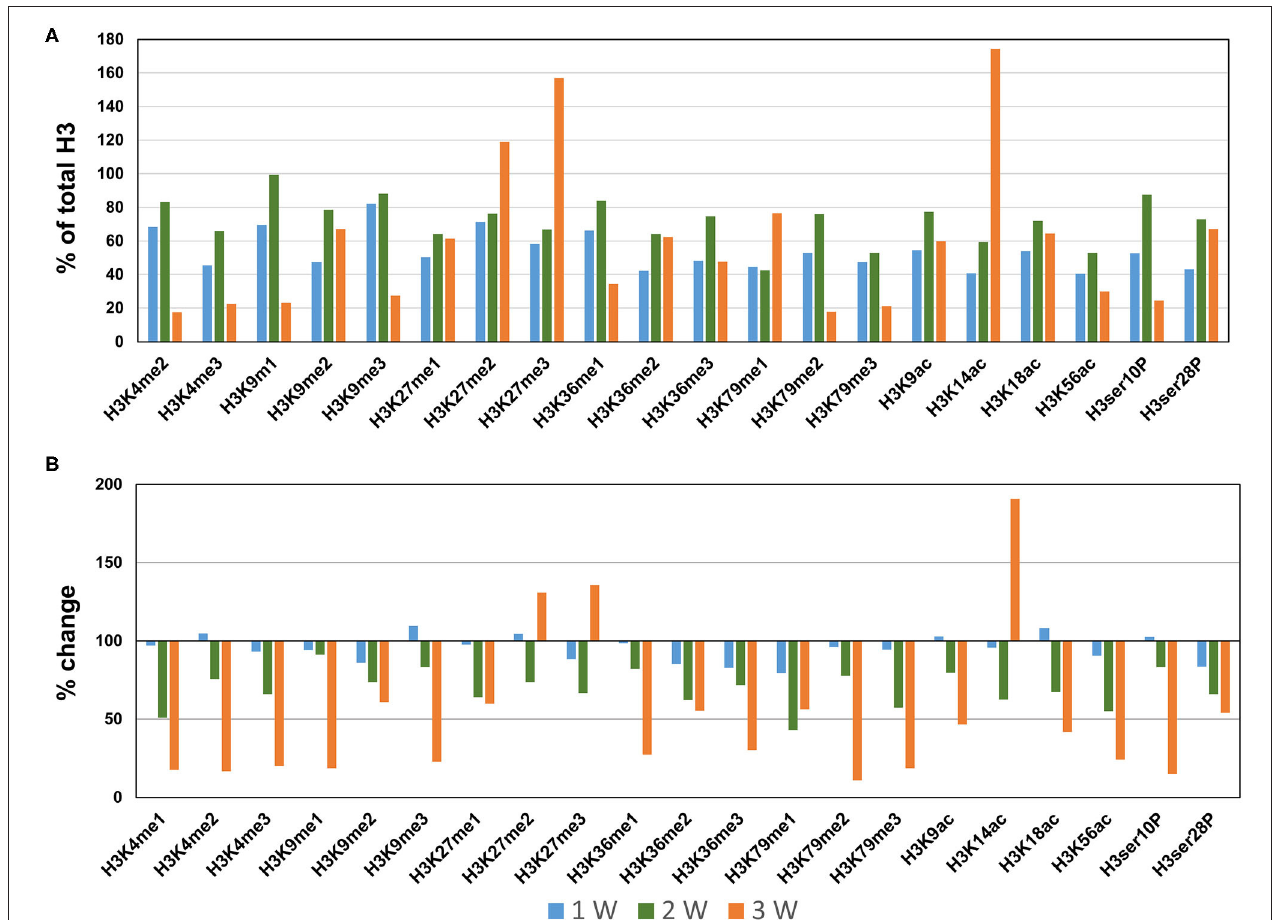
FIGURE 4 | Profiling of major histone H3 modifications in CaCl 2 -induced AAA tissues. Total histone proteins were extracted from AAA tissues (at 1, 2, 3 weeks, respectively), and histone H3 modifications were quantified using profiling kits. Pooled aortic histone extracts from three mice were subjected to the assay. (A) Percentage of total histone H3. (B) Relative changes of histone H3